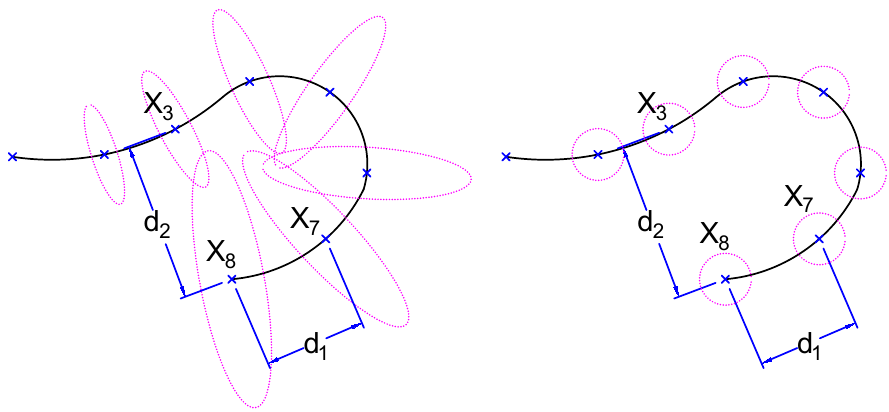
Figure 10. Example of a trajectory with uncertainty modeled by the full covariance matrix ( left ). The distance, d 2 , is statistically estimated to be smaller than d 1 . In contrast, it is the inverse when the noise is modeled with equal variances ( right